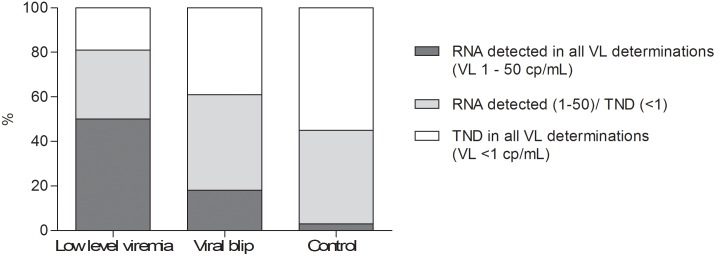
Longitudinal analysis of viral load results in preceding year.Low-level viremia is often preceded by positive VL results; in 50% of these patients HIV-1 RNA was detected in all VL determinations in the preceding year, compared to only 3% of patients with a sustained suppressed VL (p<.0001).